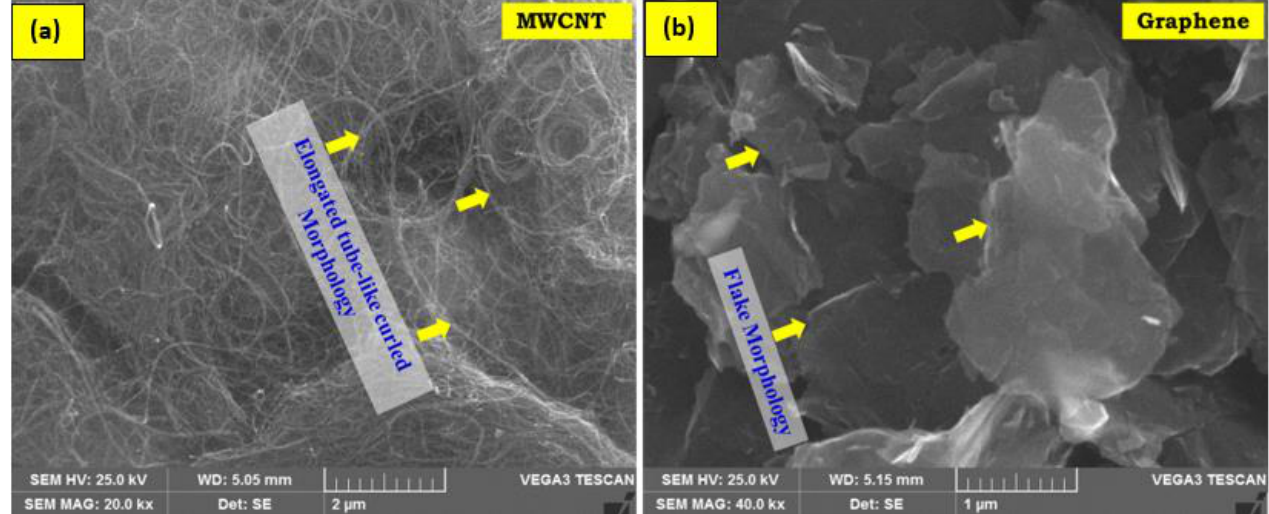
Figure 1. SEM morphologies of reinforcement materials: ( a ) MWCNT Nano-powder and ( b ) Graphene Nano-powder in pristine state.